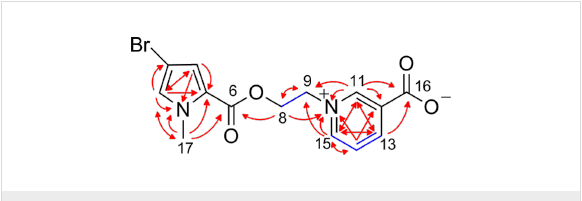
Figure 6: Selected 1 H, 1 H-COSY (blue bonds), 1 H, 13 C-HMBC, and 1 H, 15 N-HMBC (both red arrows) correlations for N -methylagelongine ( 5 ).